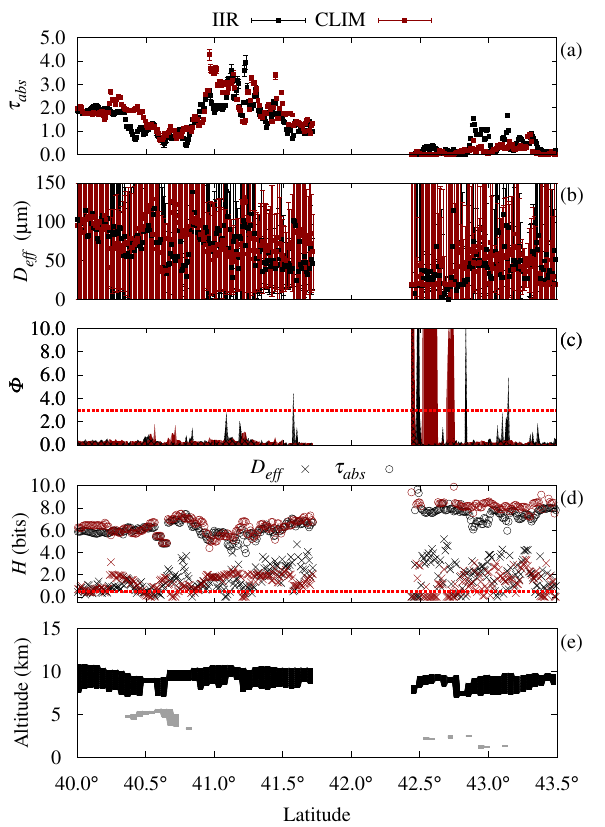
Fig. 7. Similar to Fig. 1, for 18 October 2008.